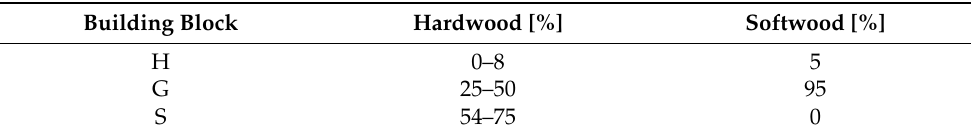
Table 1. Relative content of building blocks that constitute lignin. Data are summarized from references [12,17,18].